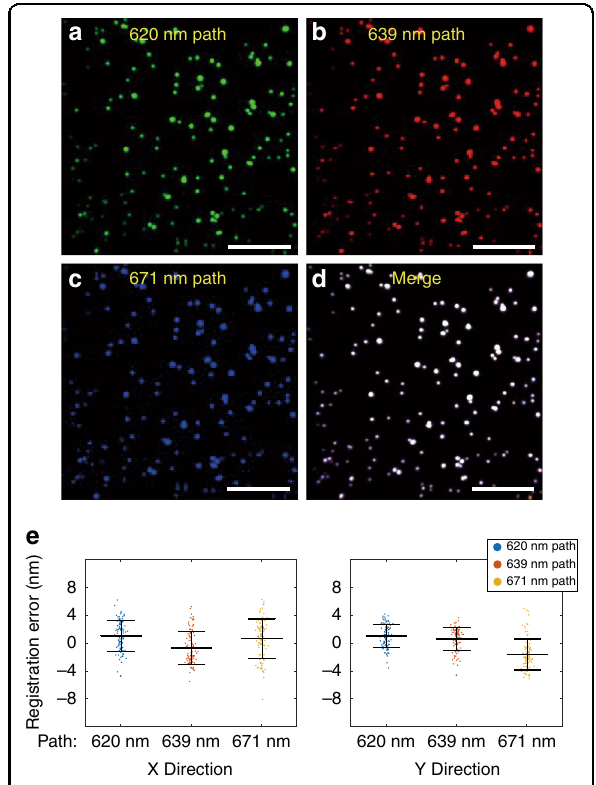
Fig. 3 Image registration and veri fi cation of co- fi tting method. 100 nm fl uorescent microspheres were used for image registration and veri fi cation. a – d Transformed images of the three light paths and merged image. e Positions of independent fi tting in each transformed channel relative to the co- fi tting results in the X and Y directions. Error bars are presented as the mean ± standard deviation. Scale bars: 10 μ m ( a – d